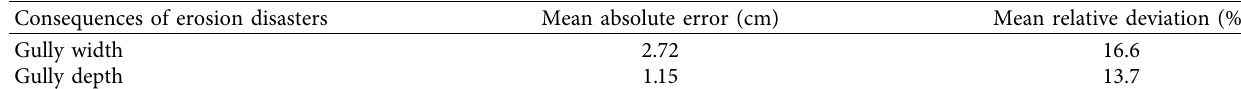
Table 7: Prediction error of erosion disaster